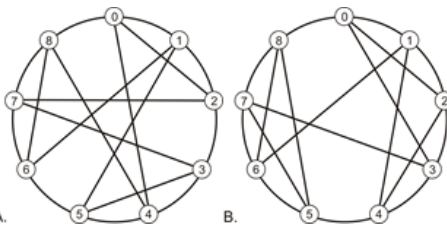
Figure 1. Nine-node Reference